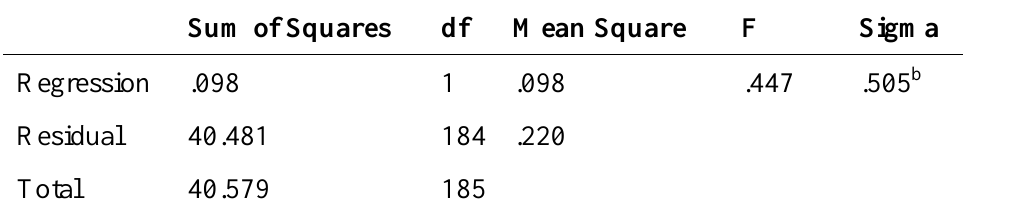
Table 7. Table of Analysis of Variance